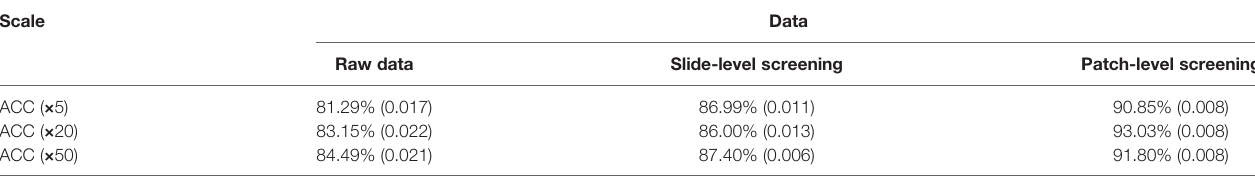
TABLE 1 | Comparison of convolutional neural network model performance on multiple-scale datasets with different magni fi cations.